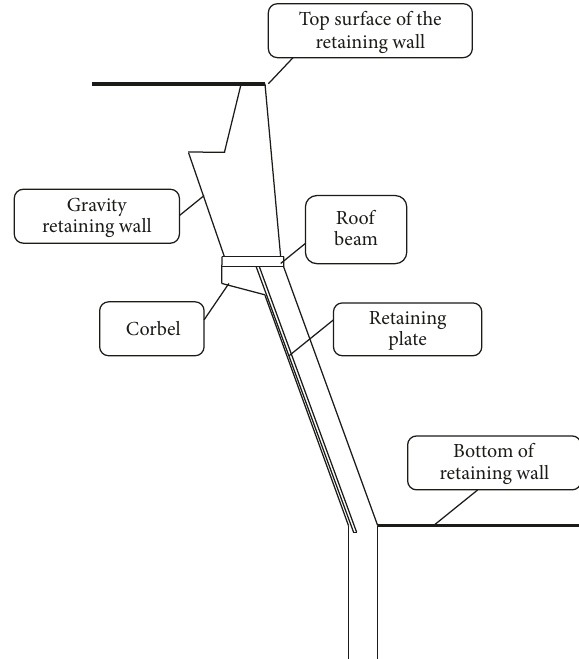
Figure 2: Sketch map of the balance of retaining